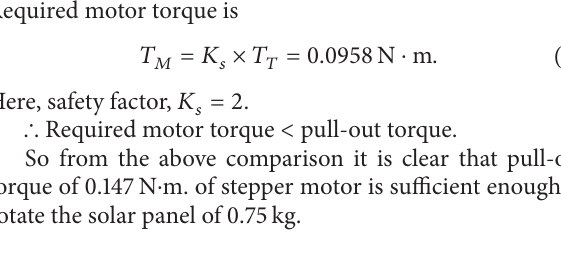
Required motor torque is